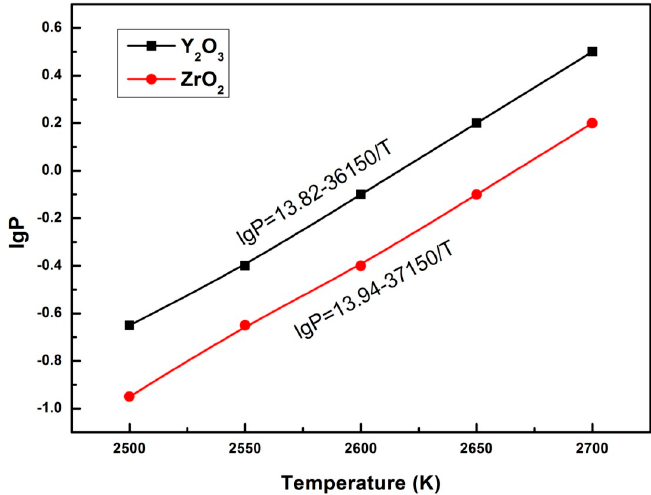
Figure 8. Relationship between temperature and vapor pressure of Y 2 O 3 and ZrO 2 .